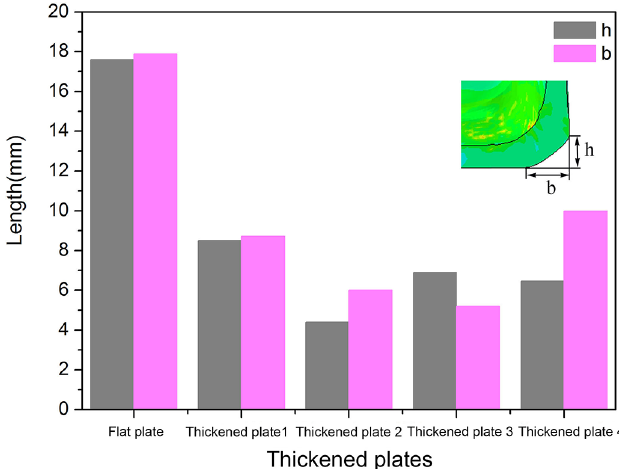
Fig. 17. Thickness distributions of hot stamped square cups with various thickened plates. Fig. 18. The values of h and b with various thickened